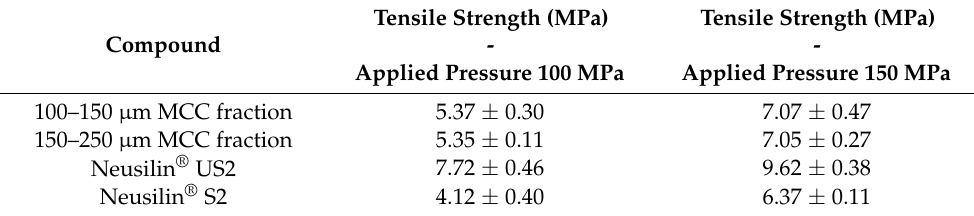
Table 5. Tensile strength of tablets compacted from pure